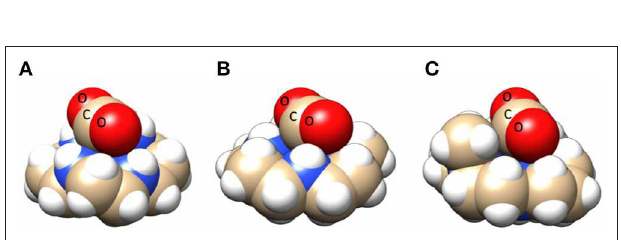
FIGURE 12 | Space-filling models of trans I [Ni(cyclam)(CO 2 )] + (A) , trans III [Ni(cyclam)(CO 2 )] + (B) , and [Ni(DMC)(CO 2 )] + (C) . Structures indicate that enhanced CO 2 reduction in the case of trans I [Ni(cyclam)(CO 2 )] + may be due to increased stabilization of the CO 2 adduct through increased hydrogen bond donors oriented toward the hydrogen bond accepting O atoms on the CO 2 adduct. Used with permission from Song et al. (2014). Copyright American Chemical Society